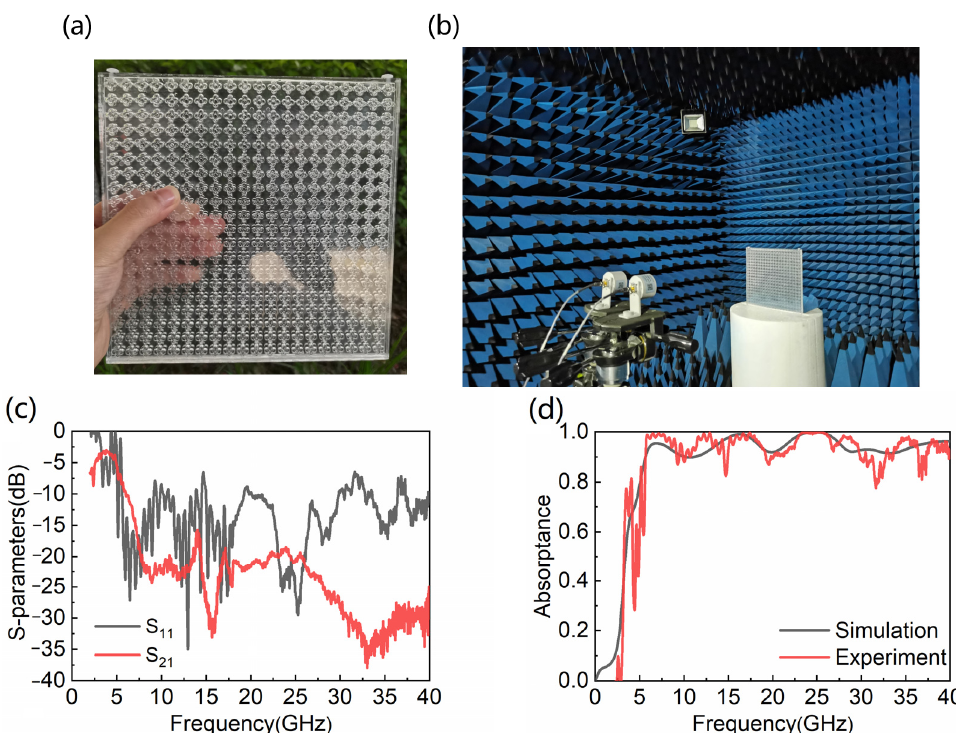
Figure 11. ( a ) Experimental sample; ( b ) experimental environment; ( c ) measured S 11 and S 21 ; ( d ) absorptance of simulation and experiment.